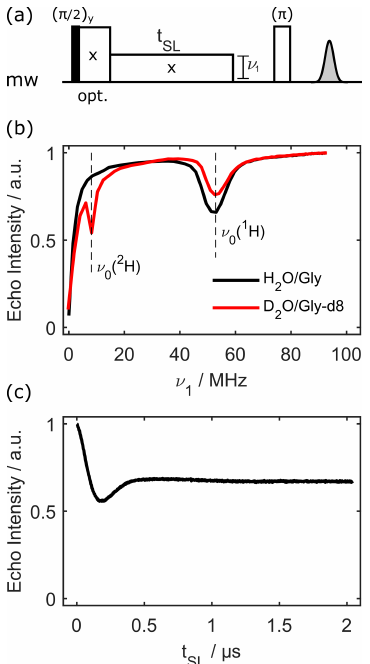
Figure 1. Electron spin depolarisation during electron spin locking. Panel (a) displays the pulse sequence. The spin lock can optionally start at full power to purge off-resonance effects. Panel (b) shows the depolarisation power (or nutation frequency) matching with a fixed spin-lock length of t SL = 2µs for 100µM OX063 at 80K. Panel (c) presents the electron depolarisation curve for the sample in protonated solvent, with the microwave power adjusted to the proton Larmor frequency, ν 1 = ν 0 ( 1 H), as determined in panel (b)